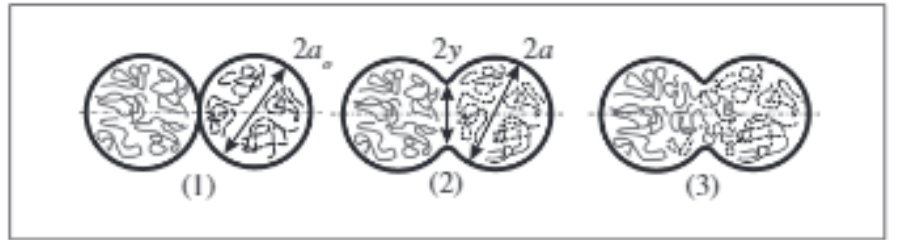
Figure 5. Bead–bead interaction and bond formation mechanism. ( 1 ) Contact between deposited beads. ( 2 ) Neck formation. ( 3 ) Polymer chains diffusion. Reprinted with permission from reference [44]. Copyright 2004, Elsevier.